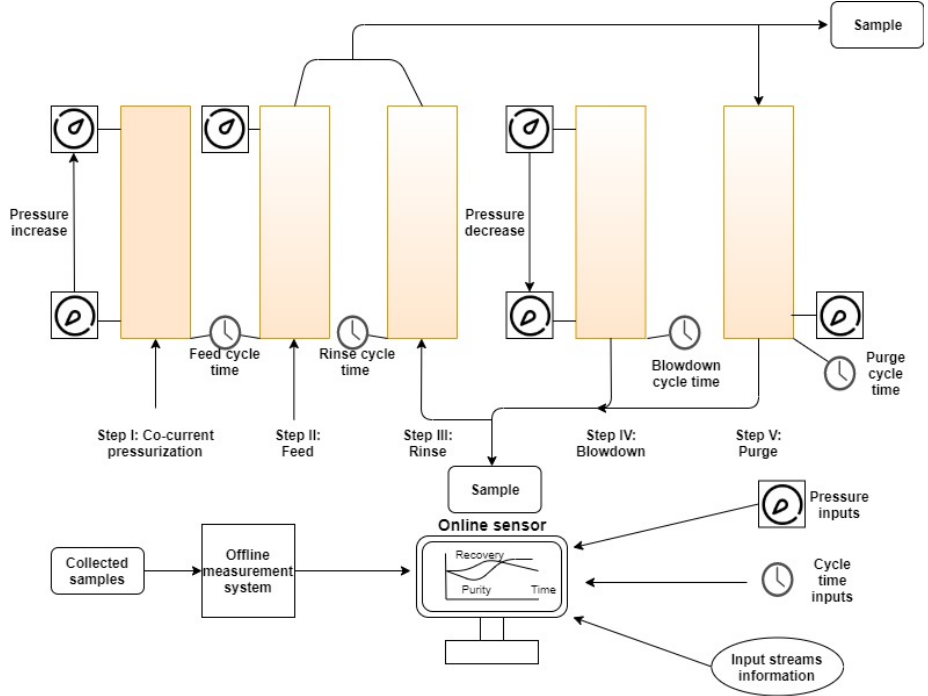
Figure 1. Representation of the proposed measurement system for the PSA unit.